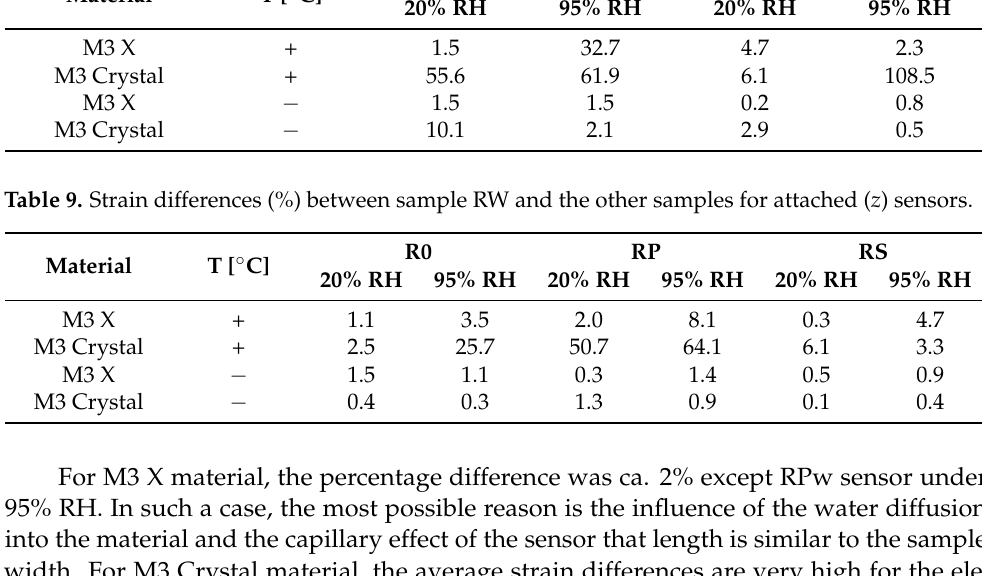
Table 8. Strain differences (%) between sample RW and the other samples for embedded ( w ) sensors. Material